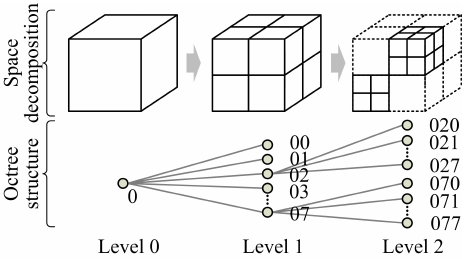
Figure 2. Octree decomposition of the 3D